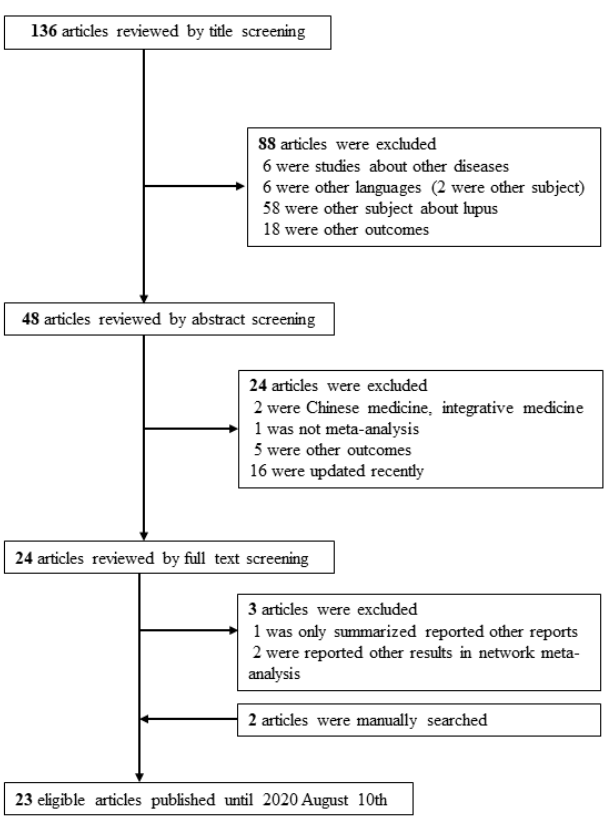
Figure 1. Flow chart of literature search.